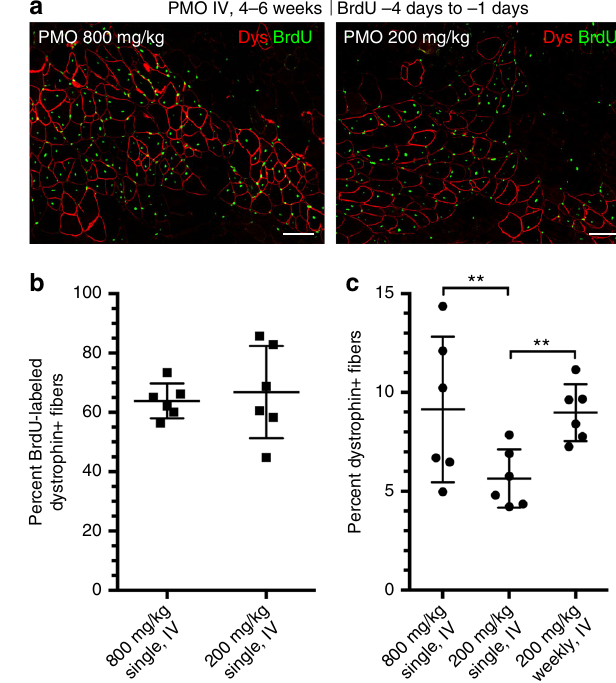
Fig. 10 Role of myo fi ber repair in productive exon skipping consistent between low and high systemic PMO doses. a Dystrophin restoration and BrdU co-localization observed in 4 – 6 week mdx mice (i.e., triceps, gastrocnemius) after single, systemic dose of PMO (200 or 800 mg/kg, n = 3). BrdU administered for 72 h prior to IV PMO delivery. Dystrophin (Dys, red ) and BrdU +ve myonuclei ( green ) 14 days after PMO. Scale bars represent 100 μ m. b Quanti fi cation of dystrophin and BrdU co-localization after 200 or 800 mg/kg PMO shown as percent of labeled fi bers. c Quanti fi cation of dystrophin-expressing fi bers after a single dose of 200 or 800 mg/kg or 4 weekly 200 mg/kg doses shown as percent of total fi bers per cross-section. Data represented as scatter plot with